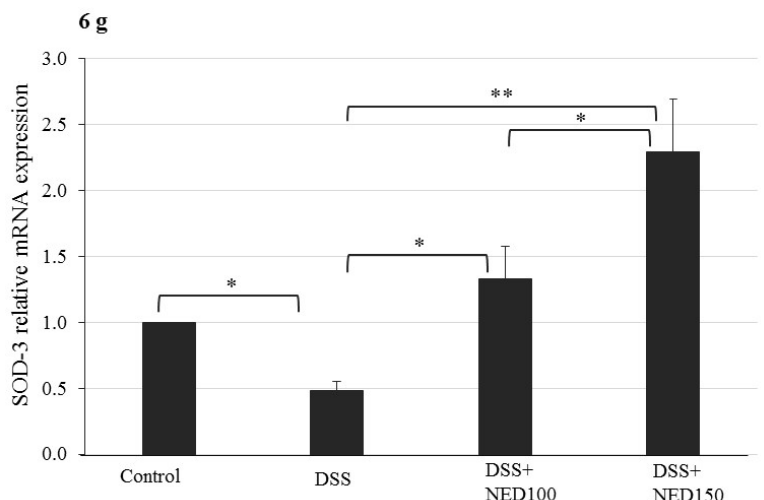
Figure 6. E ff ect of NED on Keap-1 and Nrf-2 and antioxidant system. At the two higher concentrations, NED prevented the DSS-induced increase in Keap-1 protein expression ( a ). The nuclear translocation of the Nfr-2 protein was enhanced by NED treatment in DSS-induced colitis ( b , c ). Superoxide dismutase (SOD) and catalase enzyme activities were significantly increased in NED-treated DSS colitis animals ( d , e ). Heme Oxygenase-1 (HO-1) and SOD3 mRNA expression were also significantly increased in NED-treated DSS colitis in mice ( f , g ). Data were obtained from n = 4 animals for the Western blot studies, n = 6 for enzyme activity and mRNA level. Data expressed as means ± SEM. *** p ≤ 0.001. ** p ≤ 0.01. * p ≤ 0.05. p values were obtained by one-way ANOVA followed by Tukey’s multiple comparison test using SPSS software, and p ≤ 0.05 was considered statistically